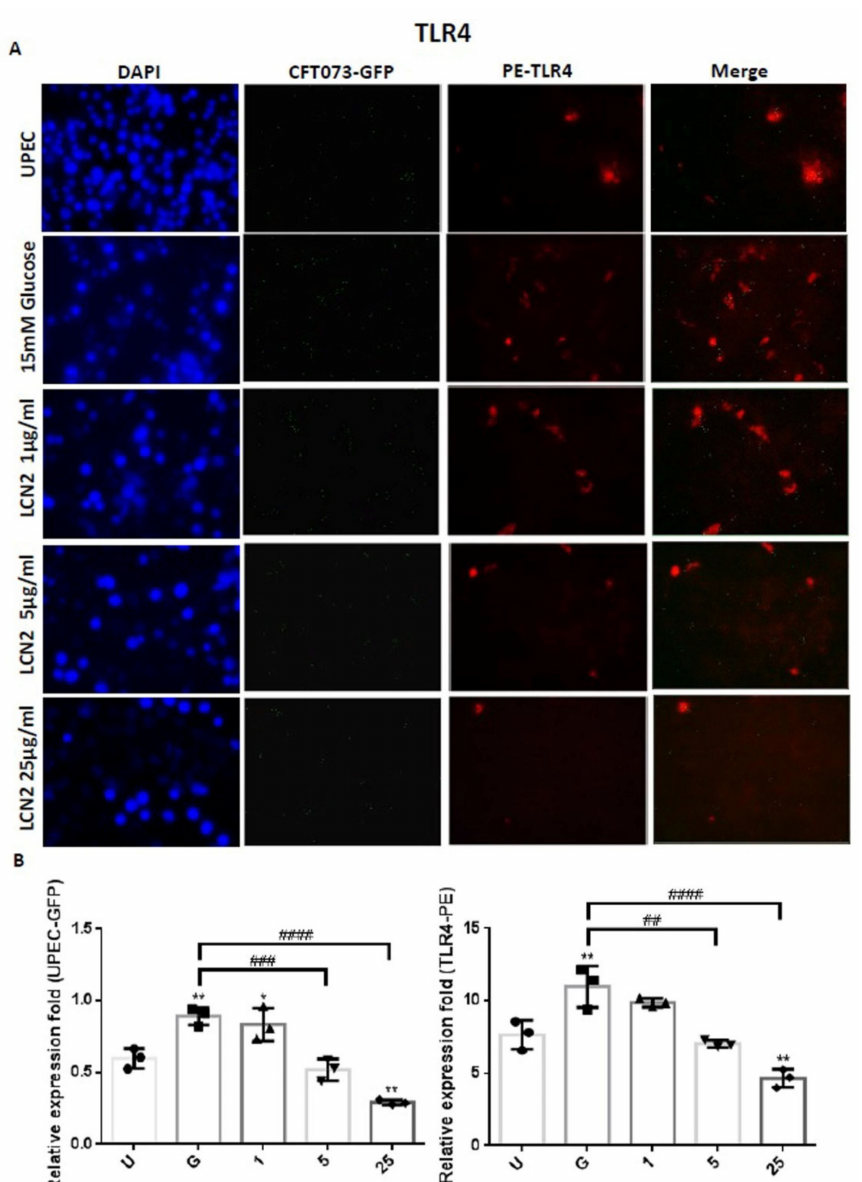
Figure 4. LCN2 decreased UPEC infections and TLR-4 expression in bladder cells. SV-HUC-1 cells were first pretreated with 15 mM glucose, followed by treatment with different concentrations of LCN2 (1, 5, and 25 µ g/mL) for 24 h and infection with pGFP-UPEC (MOI of 1:100) for 4 h, as described in the text. The definitions of the letters on the X axis: U, UPEC infection alone; G, with 15 mM glucose pretreatment alone. GFP-UPEC and PE-TLR-4 expression in SV-HUC-1 cells, for 4 h postinfection, were ( A ) observed by fluorescence microscopy and ( B ) measured using ImageJ software. Cells infected with UPEC alone were used as positive controls. The pictures shown are representative of typical results. DAPI was used to count the number of cells and as a standard for calculating the fluorescence expression ratios of cells. Cell images were captured using a microscope (Leica) at 100 × magnification. The data are expressed as means ± SDs from three separate experiments. An analysis of variance was used to evaluate differences between various treatment groups and controls. Statistical differences between groups were determined using the Mann–Whitney U Student’s t -test. Statistical significance was set at p < 0.05. * p < 0.05, ** p < 0.01 compared to the positive control groups. ## p < 0.01, ### p < 0.001, #### p < 0.0001 for comparisons between two